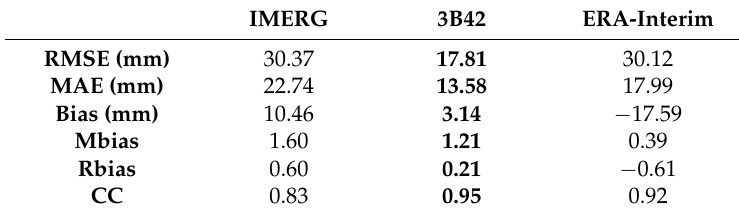
Figure 12. Guilan seasonal precipitation. Table 13. Statistical indices of seasonal precipitation in Bushehr area.